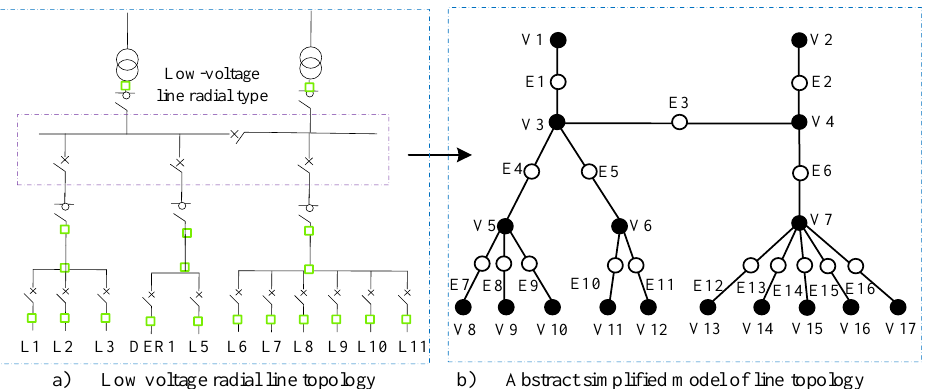
Figure 1. Simplified topology model of a low-voltage distribution network. Table 1. Connection table of Figure 1. Vertex